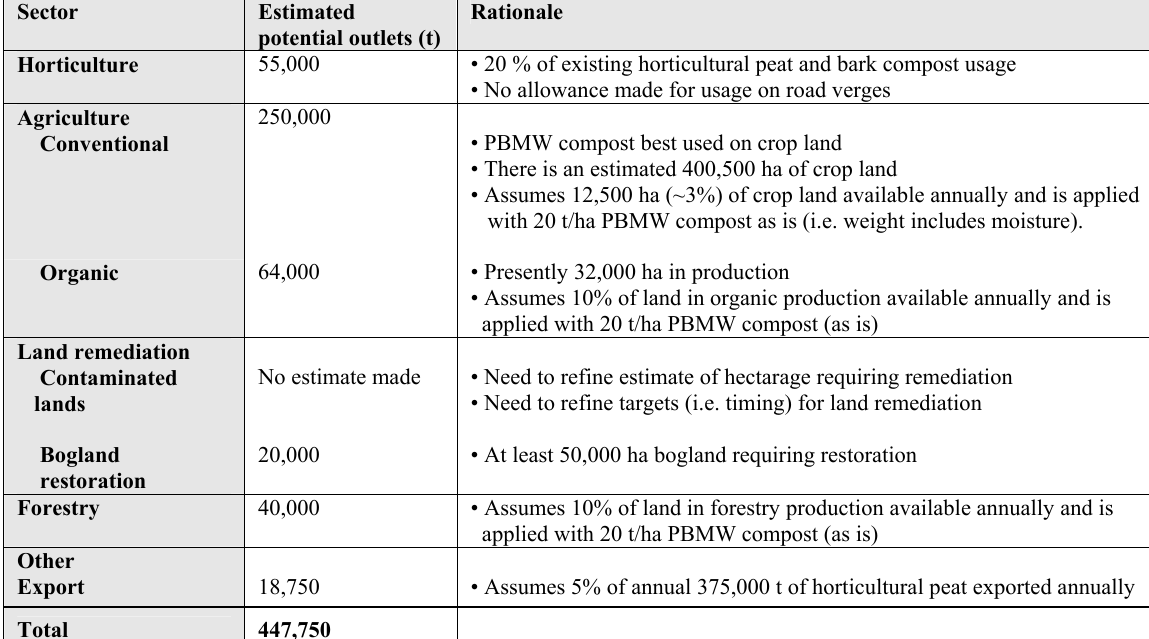
Table 47: Estimates of potential annual outlets for Putrescible Biological Municipal Waste PBMW